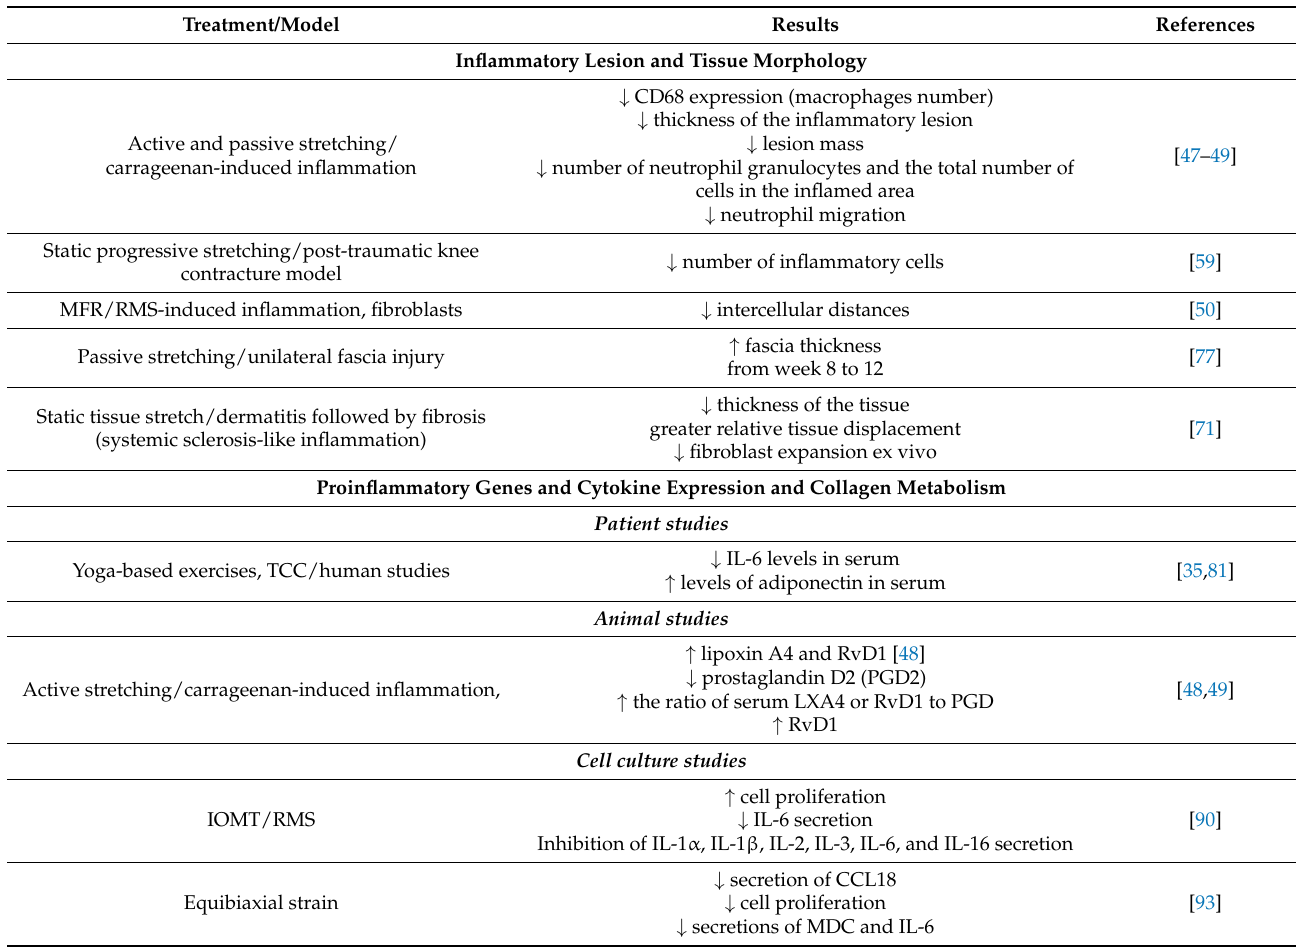
Table 1. Table summarizing anti-inflammatory effects of